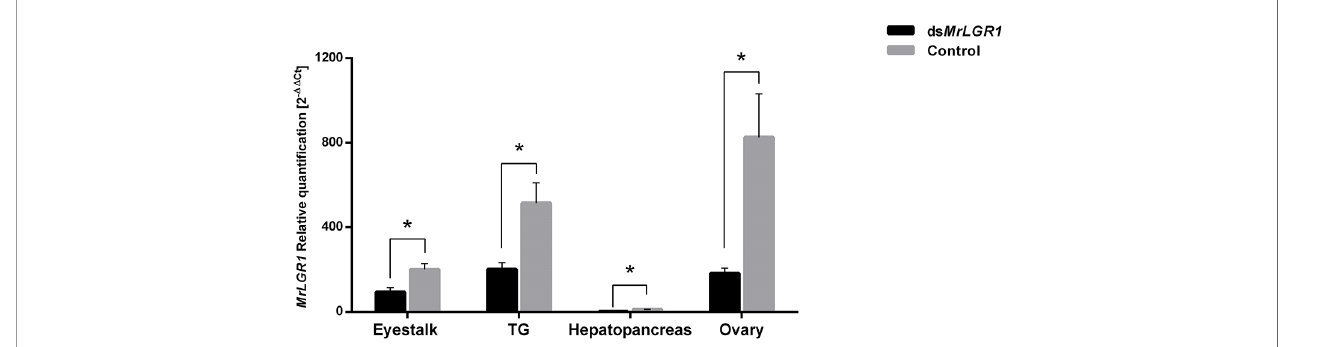
FIGURE 7 | Long-term MrLGR1 loss of function through RNAi. Females were injected with ds MrLGR1 (n = 6) or with dsGFP (control; n = 4). MrLGR1 relative transcript levels in the eyestalk, TG, hepatopancreas and ovary. Error bars represent standard error of the means. Asterisks indicate statistically signi fi cant differences ( P < 0.05,